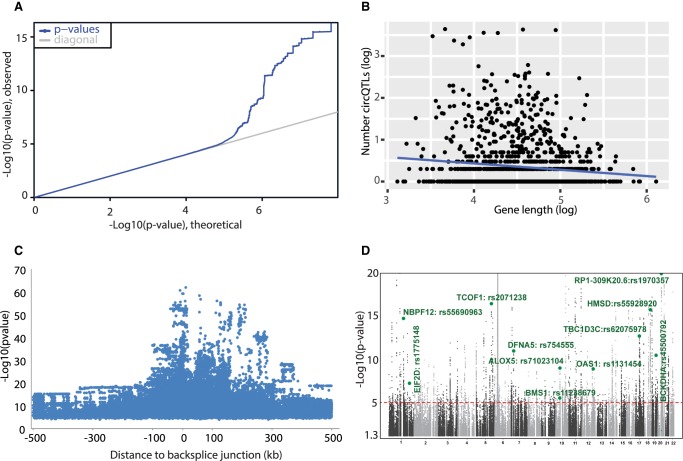
Summary plots of association statistics. (A) Q–Q plot distribution of all recorded P-values for chromosome 22. (B) Scatterplot of gene length versus number of identified circQTL SNPs for each gene. The number of identified circQTL SNPs shows a uniform distribution with respect to gene length as indicated by the line of best fit (blue line). (C) The distribution of statistical significance of association for circQTL SNPs against proximity to circular RNA. (D) Manhattan plot of association statistics. The −log10(P-value) is plotted against the physical positions of each SNP on each chromosome and have been capped to P = 1 × 10−20. The genome-wide significance threshold of 8.4 × 10−06, obtained as the median of the unadjusted P-values for the best circQTL of each ecircRNA, is shown as a horizontal red line.